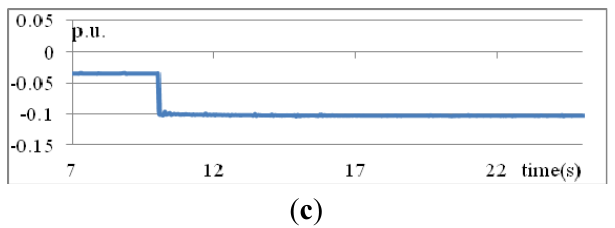
Figure 8. MVARs from STATCOM obtained using three methods: ( a ) traditional PID; ( b ) T1 fuzzy rules; ( c ) IT2 fuzzy rules (Scenario 1).